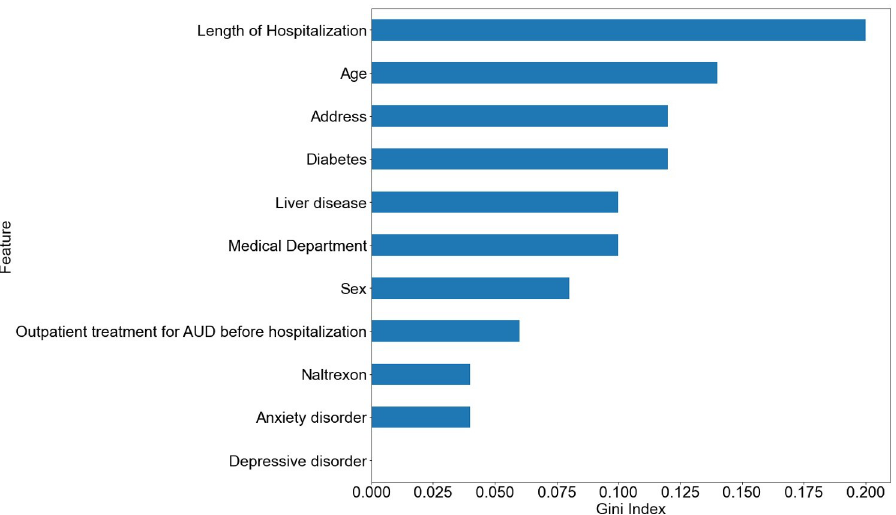
Fig 4. Feature importance of AdaBoost decision